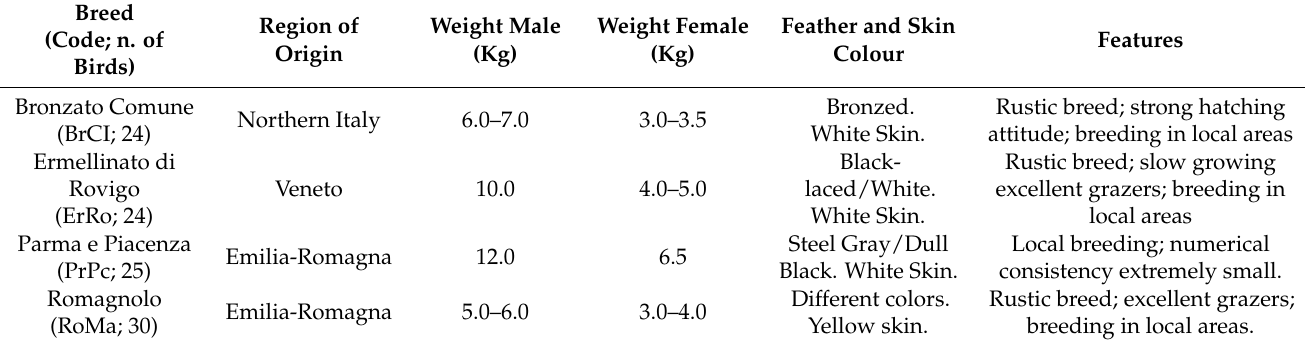
Table 1. Description of breeds included in the study. Weight at adult